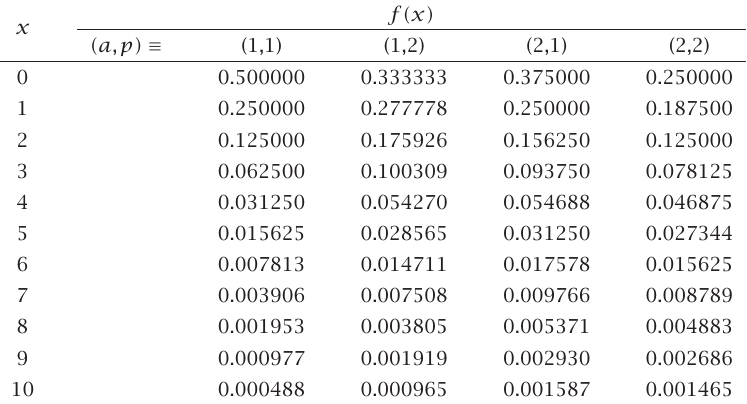
Table 4.1 . Calculating f(x) of HGNB ( 1 ,a,p) using the recurrence relation